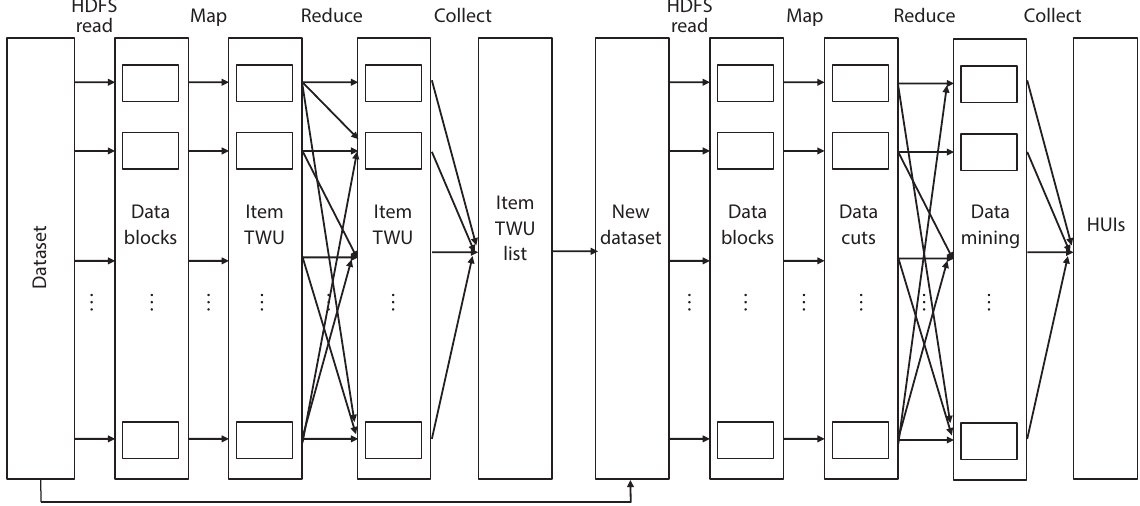
Fig. 1 Flowchart of the proposed P-EFIM